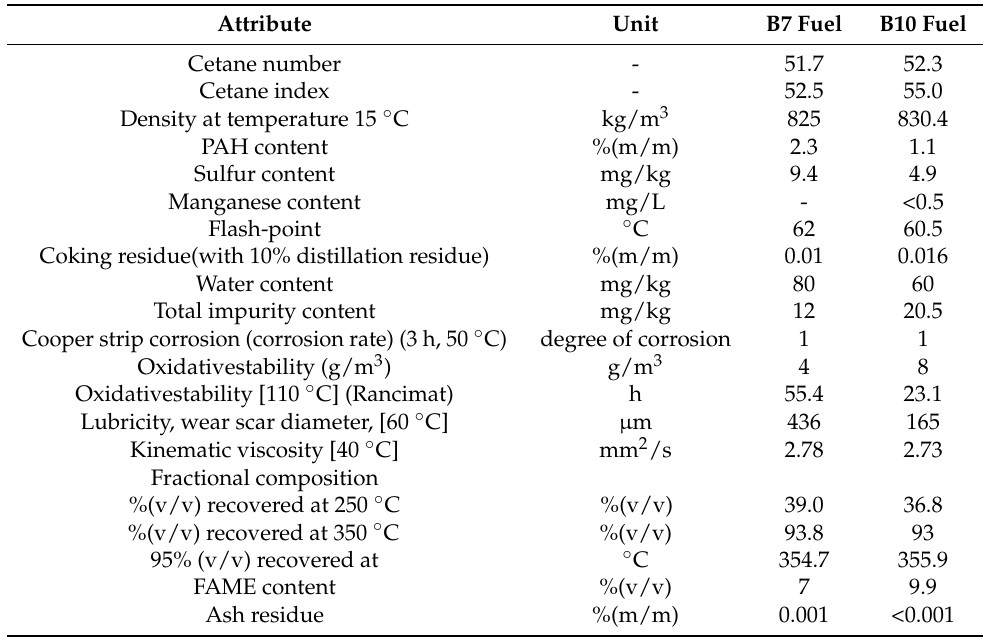
Table 1. Base fuel characteristics